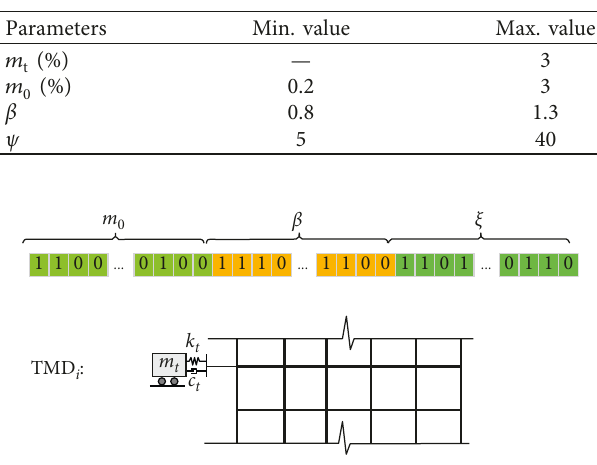
Figure 5: Binary coding the TMD’s properties.